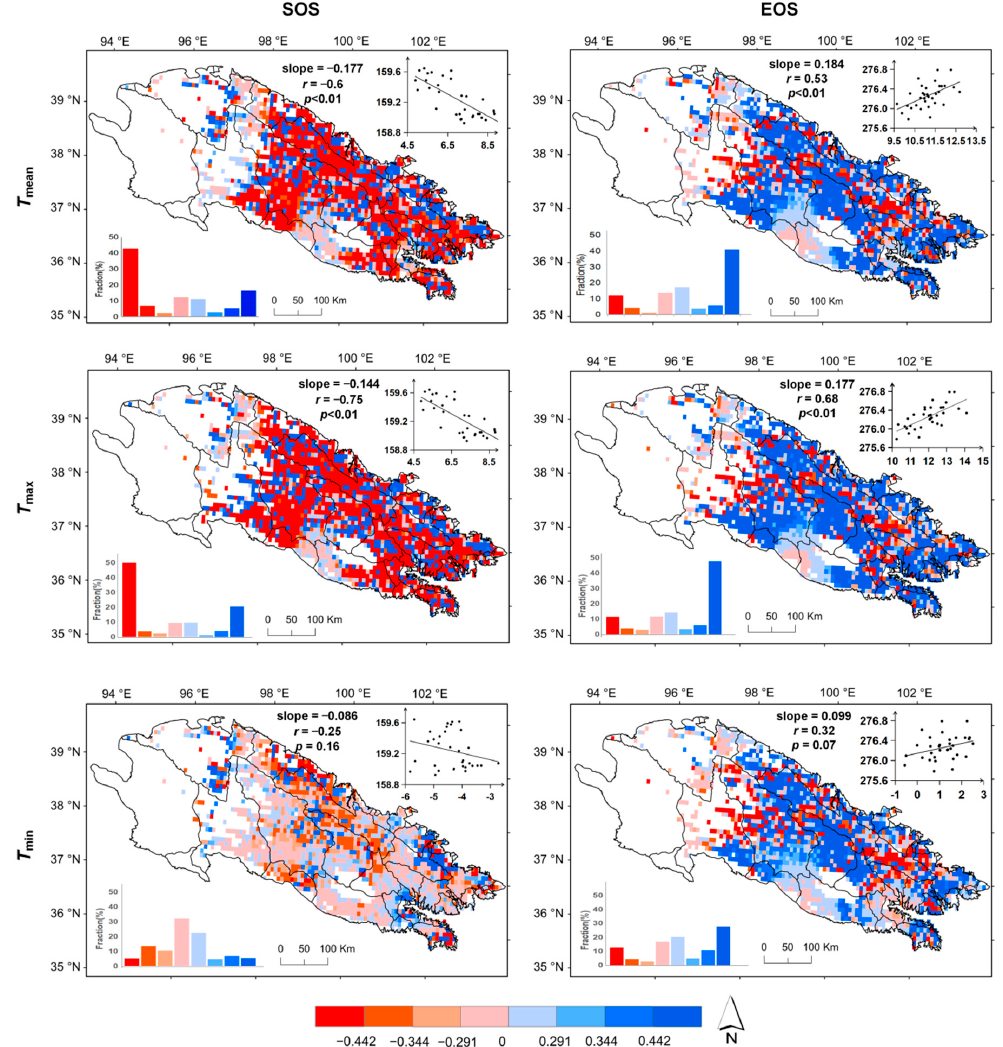
Figure 6. The spatial distribution of correlation coefficients between the phenology (SOS, EOS) and temperature ( T mean , T max , and T min ) in the Qilian Mountains. Correlation coefficient values of ±0.442, ±0.344, and ±0.291 were at the significance levels of 0.01, 0.05, and 0.1, respectively. The line chart in the upper right represents the linear regression between phenology and temperature in the whole study region.